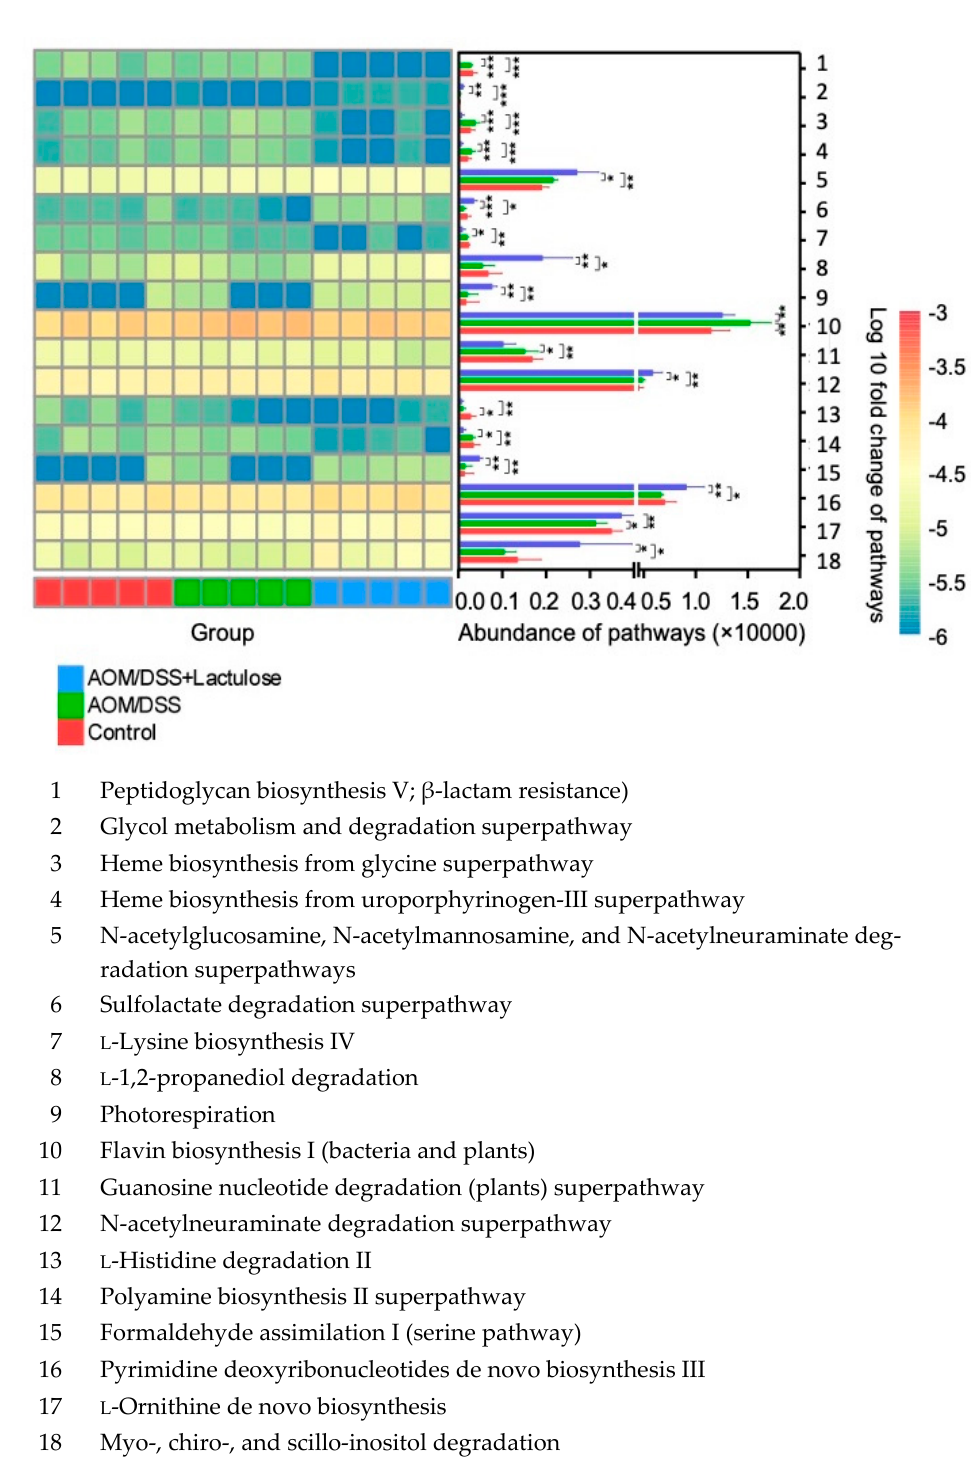
Figure 7. Differences in metabolic pathways among the three groups at T2. The top 18 pathways that showed significant ( p < 0.01) difference between three group, i.e., Control, AOM/DSS, and AOM/DSS + Lactulose at T2. The abundance (copies per Million) of the pathways in each sample is shown in the heatmap and the average abundance of each pathway in each group is shown in bar chart. The significance of control vs. AOM/DSS, control vs AOM/DSS +lactulose, and AOM/DSS vs. AOM/DSS +lactulose groups analyzed using the t -test. * p < 0.05, ** p < 0.01, *** p < 0.001 ( n = 5). Details are listed in Supplementary Tables 1 ‒ 4.